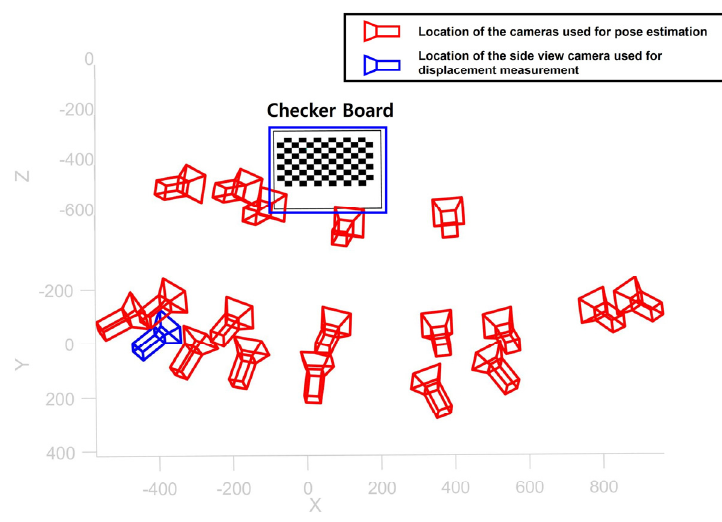
Figure 12. Camera pose estimation result for the lab-scale validation test.